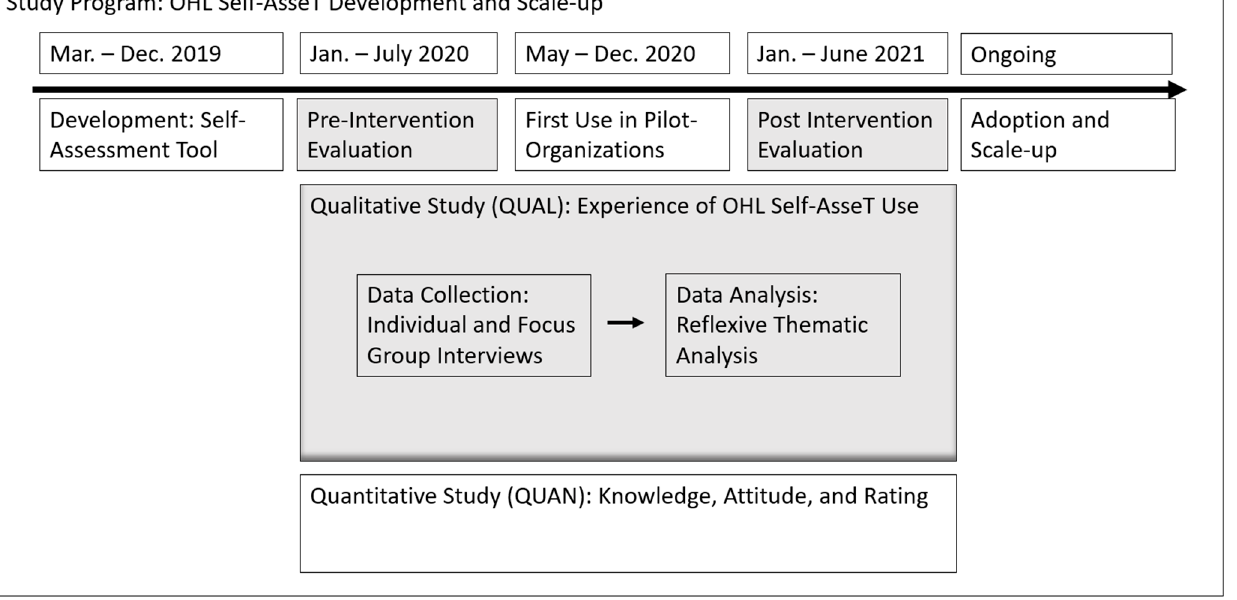
Figure 1. Embedded qualitative study design adapted from Creswell and Planto Clark, 2017 [15].